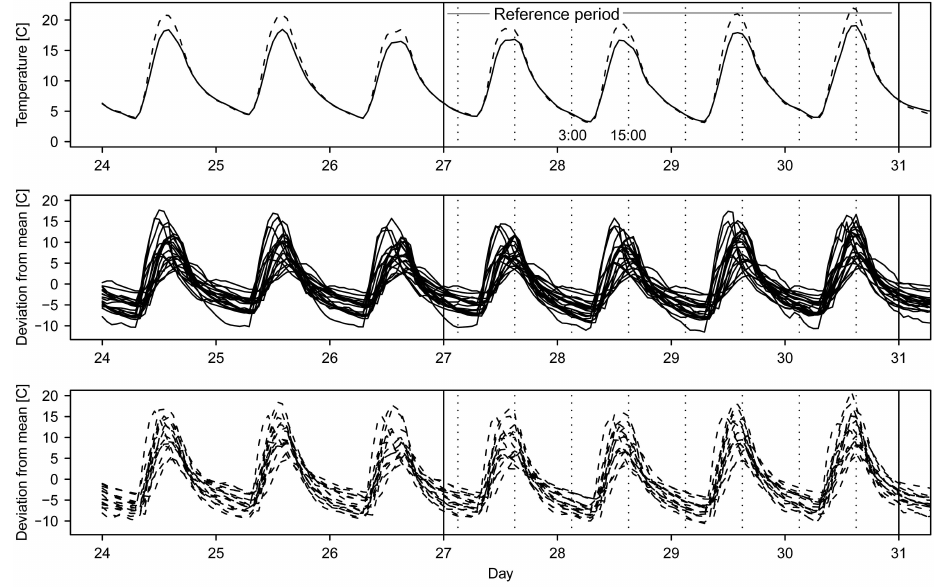
Fig. 3. Hourly NSGT time series at logger sites for location outside (solid lines) and within ice-debris landforms (dashed lines) during the 24–30 March 2009 period. The upper panel shows average NSGTs of all data loggers, the lower panels individual logger time series as deviation from each logger’s mean NSGT. The reference period is delimited by continuous vertical lines; dotted lines indicate times of daytime and nighttime NSGT readings (3p.m.,